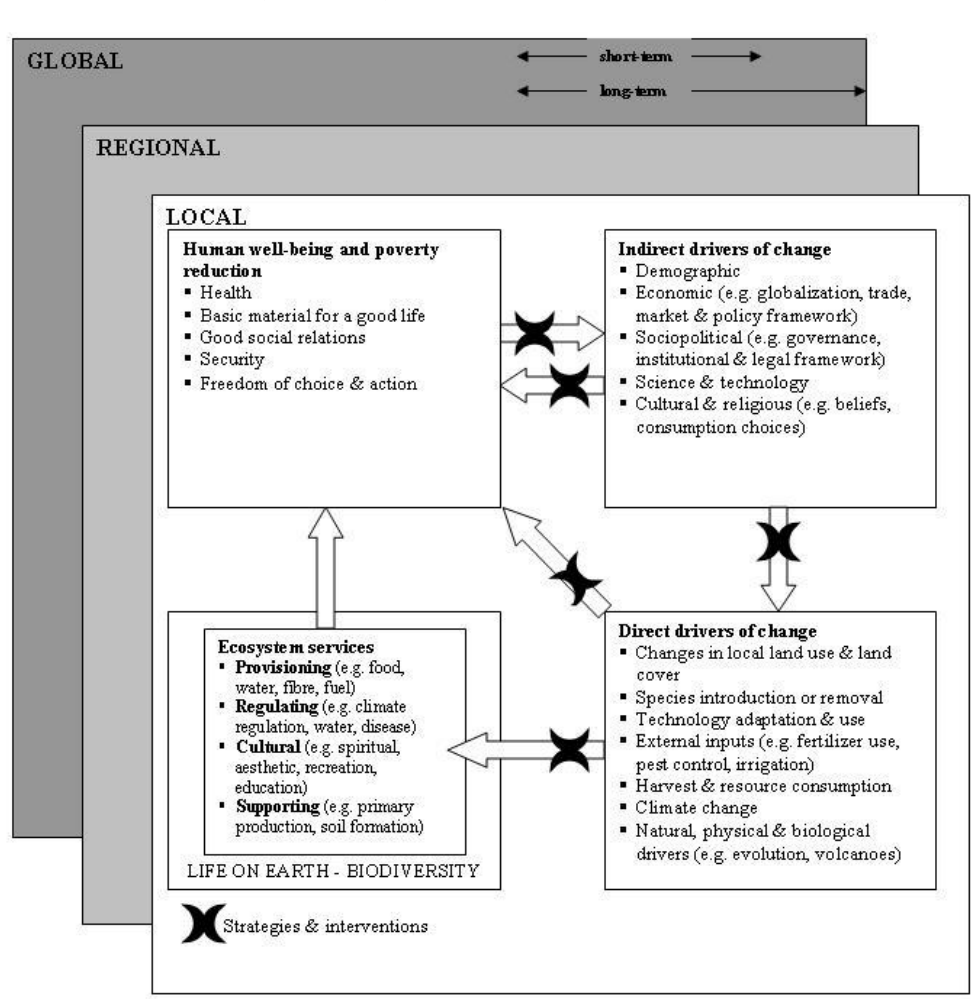
Figure 2. Millennium Ecosystem Assessment framework (reproduced with permission from [42], published by WHO, 2005). Changes in drivers that indirectly affect ecosystems (upper right box) can lead to changes in drivers that directly affect ecosystems (lower right box). The resulting changes in the ecosystem (lower left box) cause ecosystem services to change and thereby affect human well-being (upper left box). These interactions can take place at more than one scale, across scales, and across different timescales. Actions can be taken either to respond to negative changes or to enhance positive changes at almost all points in the framework (cross